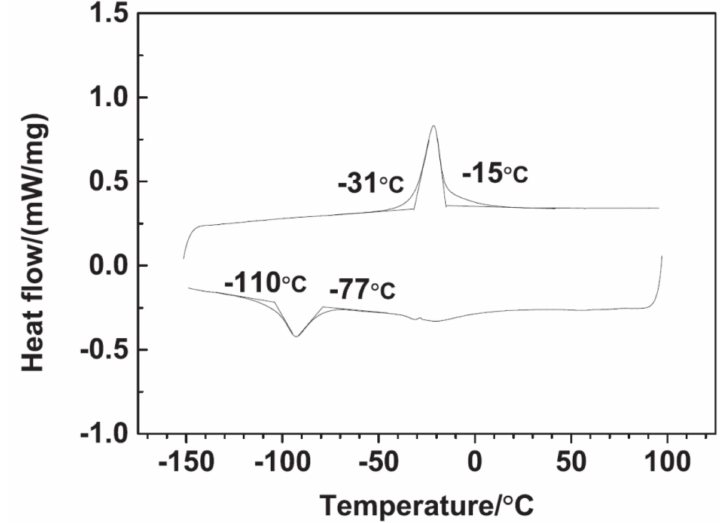
Figure 1. Differential scanning calorimeter (DSC) results of shape memory alloy